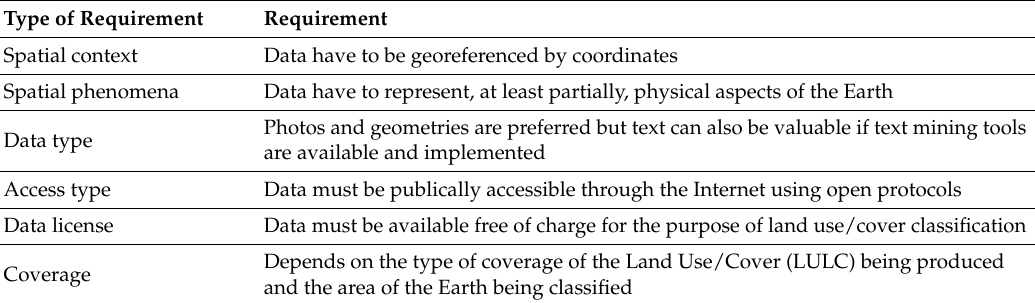
Table 1. List of essential requirements that any initiative must